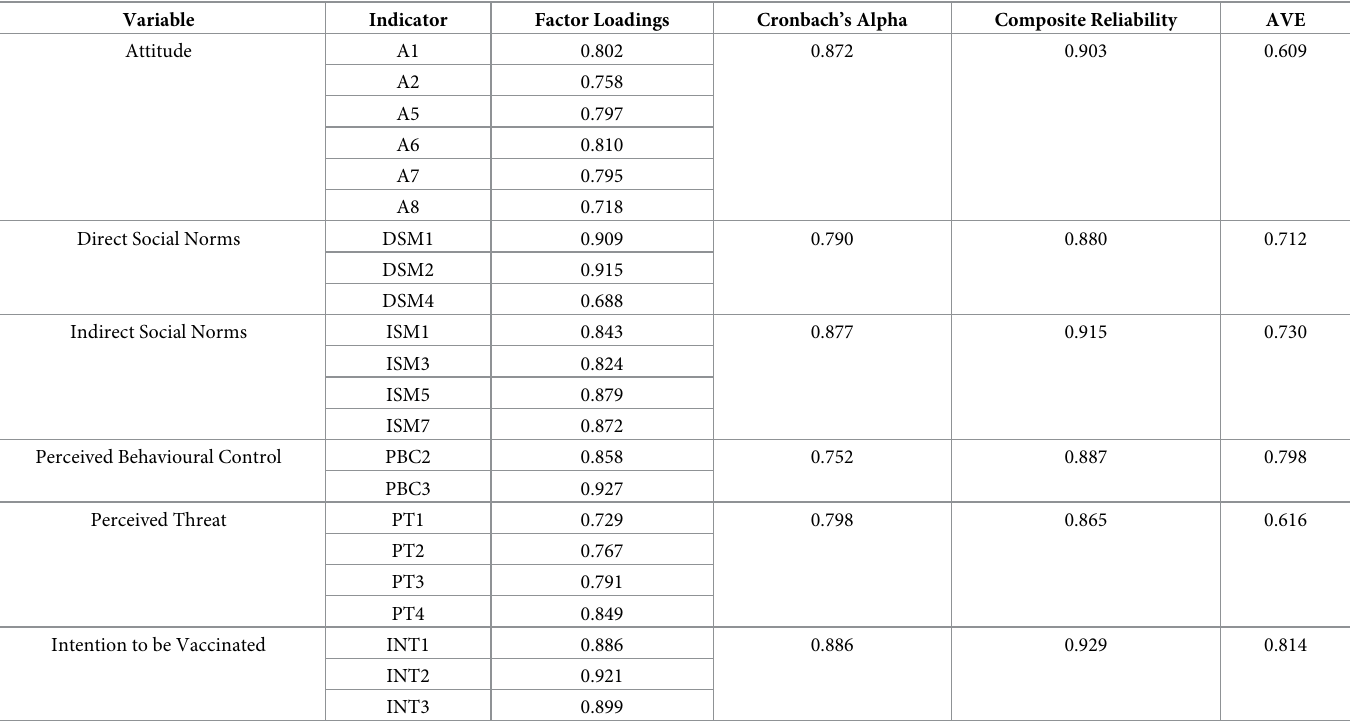
Table 4. Internal consistency, composite reliability and convergent validity.